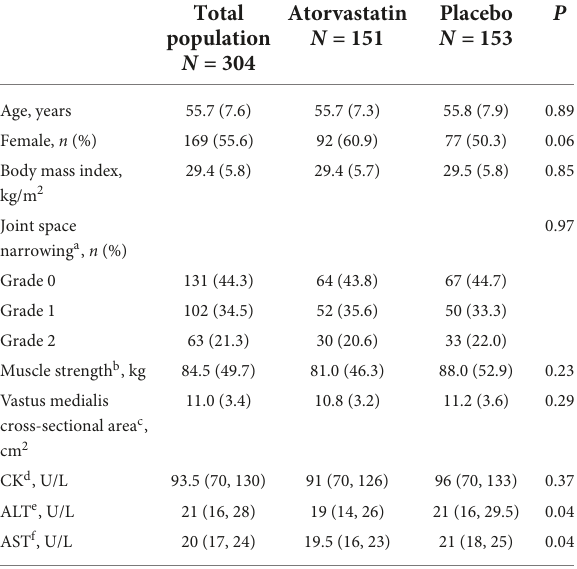
TABLE 1 Baseline characteristics of study